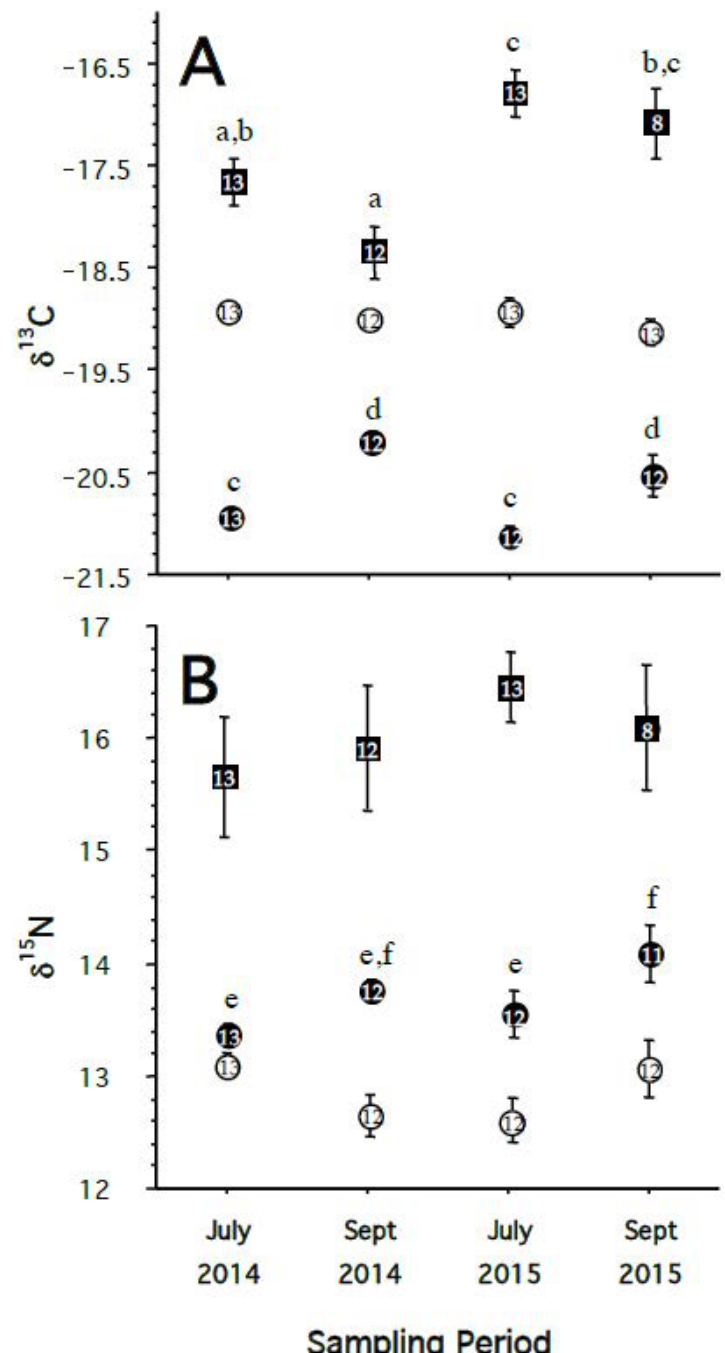
Figure 3. Comparison of δ 13 C values (panel A) and δ 15 N values (panel B) within tissues for blood plasma (black circles), red blood cells (RBCs) (open circles), and feathers (black squares). When comparing within tissues, periods that do not share letters di ff er significantly (Fischer’s PLSD, p ≤ 0.05) in the δ 13 C or δ 15 N. Standard error bars are indicated. Sample sizes are given within the